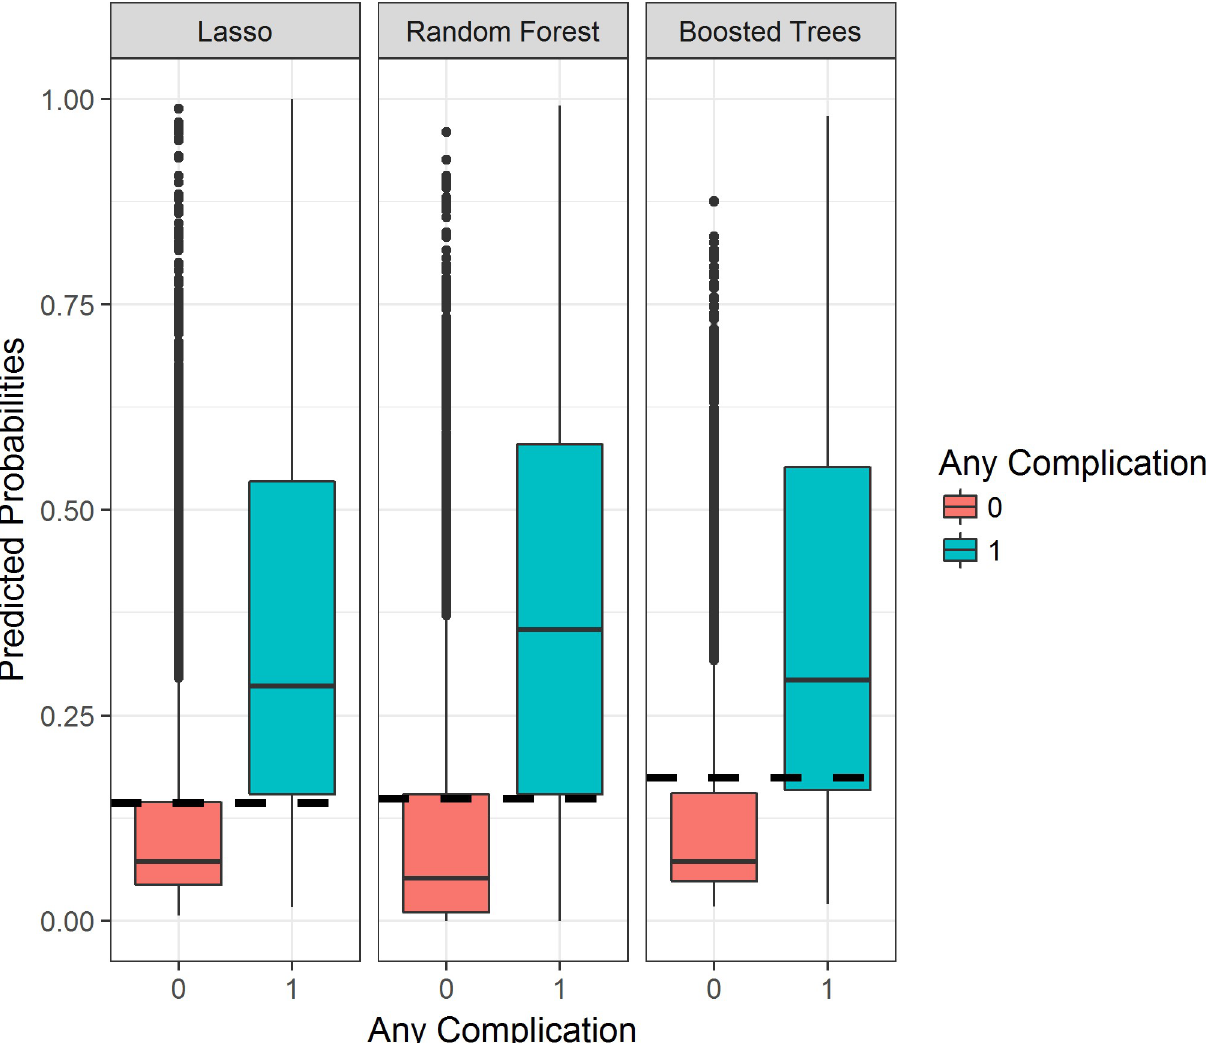
Fig 3. Boxplots displaying the model predicted probabilities for patients who experienced a postoperative complication versus those who did not. Any postoperative complication (category = 1) versus no complications (category = 0). Thresholds (dashed lines) were chosen based on these population delineations. lasso, least absolute shrinkage and selection operator.